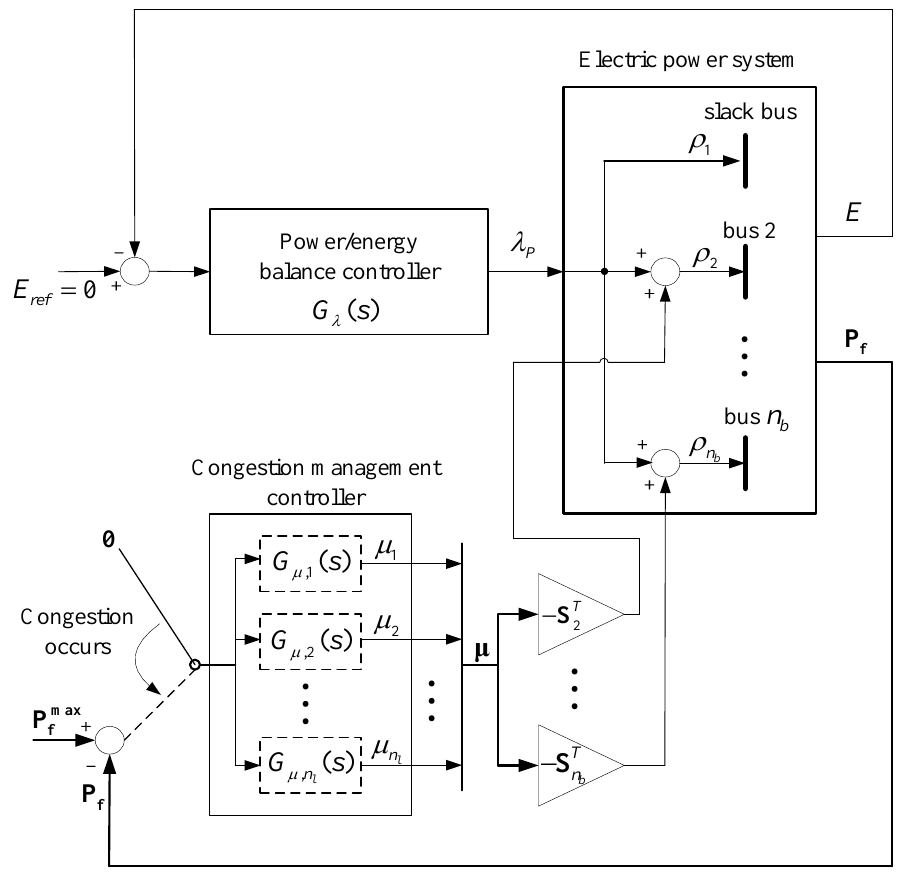
Figure 3. Overall structure of the framework for the design of optimal price-based operation.